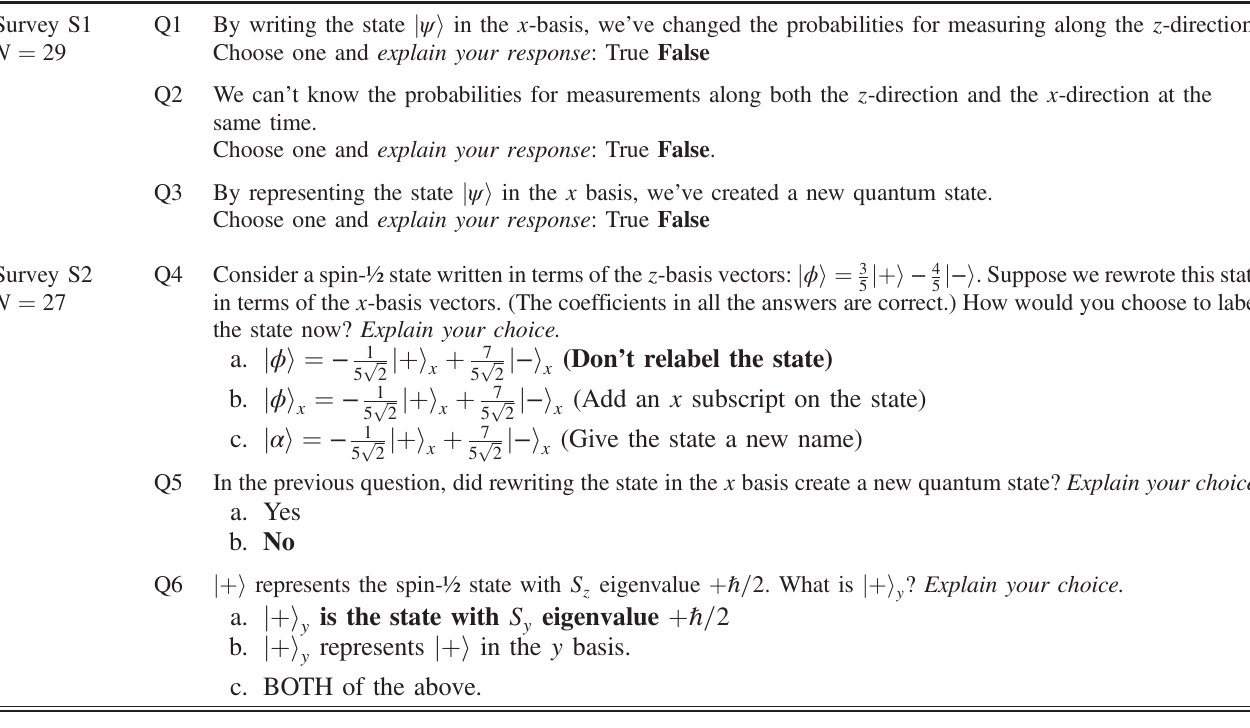
TABLE I. Survey questions targeting RQ1 regarding students ’ interpretation of a change of basis. Surveys S1 and S2 were both administered at one institution throughout a quantum mechanics course. Identical versions of surveys S1 and S2 were administered to 6 student interviewees at a second institution. Correct answers to true or false and multiple-choice questions are given in